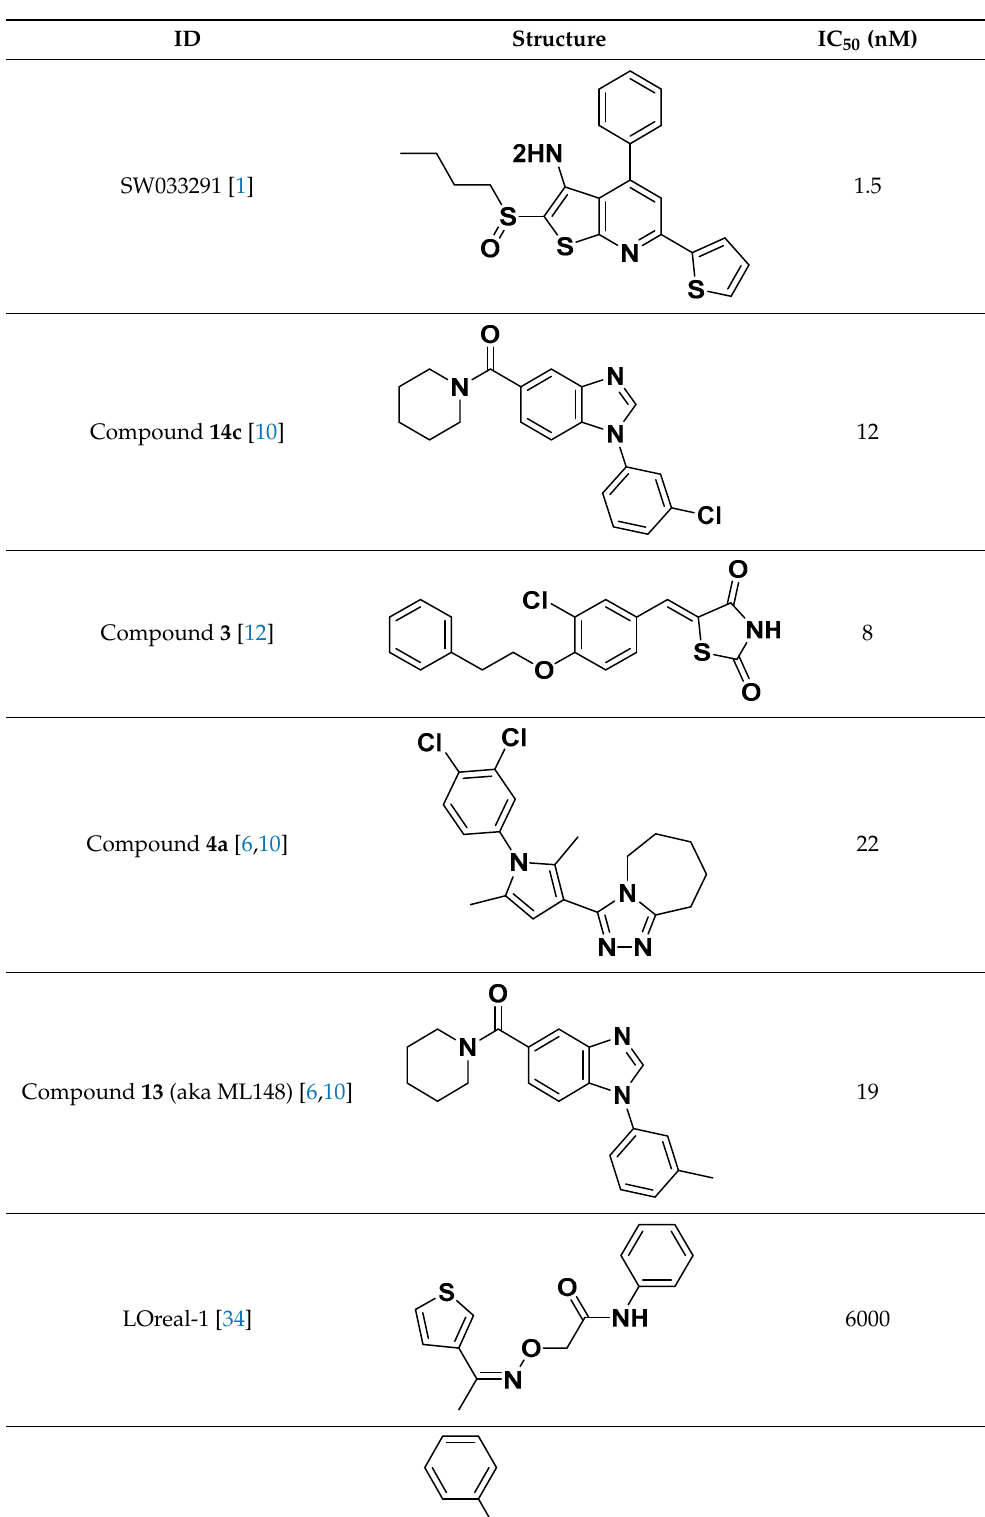
Table 1. Published structures of PGDH inhibitors.